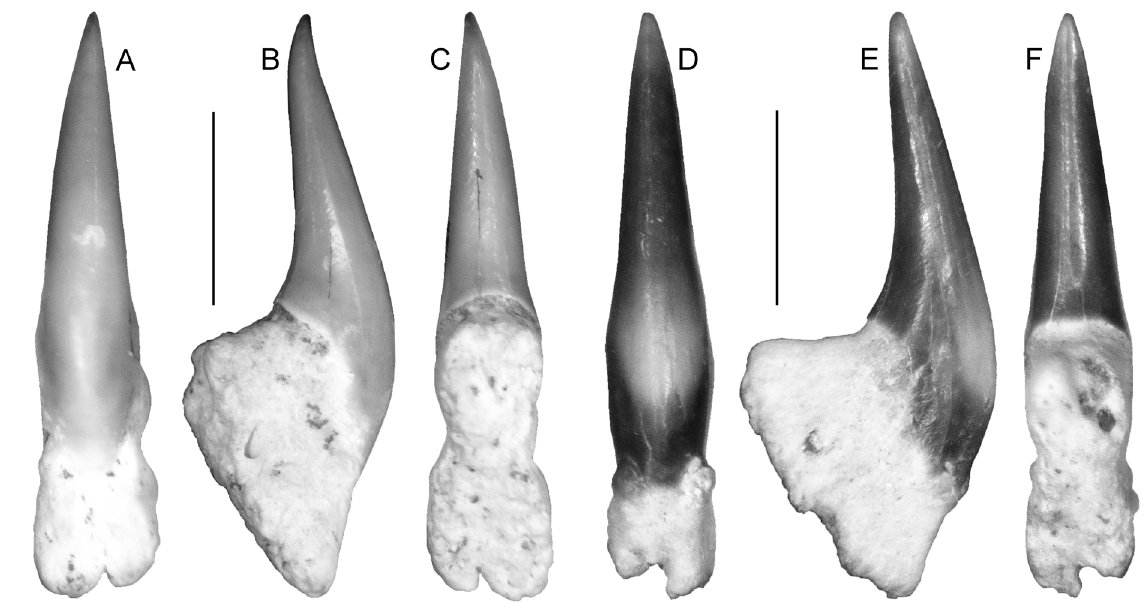
Fig. 22. Stenoscyllium cf. S. priemi Noubhani & Cappetta, 1997, teeth. A–C . MSC 35760.1, lower Tallahatta Formation. A . Labial view. B . Mesial view. C . Lingual view. D–F . MSC 35760.2, lower Tallahatta Formation. D . Labial view. E . Distal view. F . Lingual view. Scale bars = 2